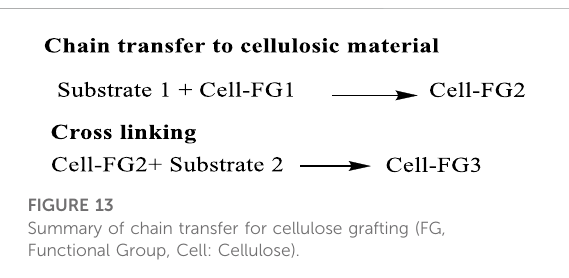
FIGURE 13 Summary of chain transfer for cellulose grafting (FG, Functional Group, Cell: